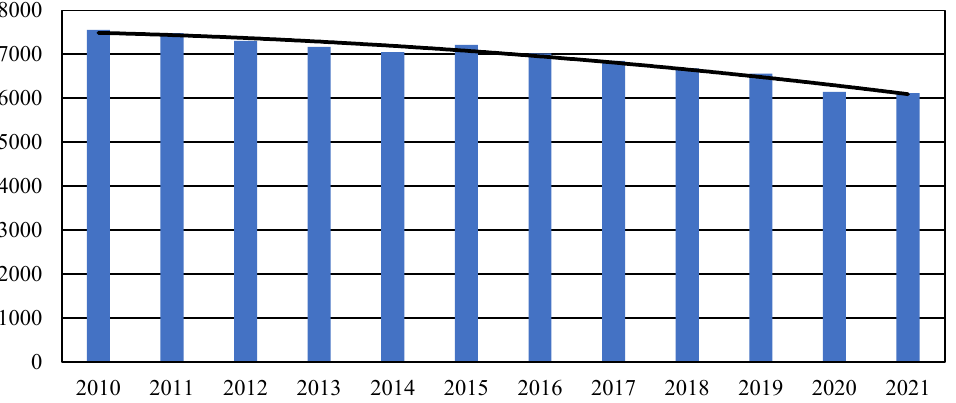
Figure 9. The potential of livestock by ‐ products for production of gas ‐ like types of fuel in the coun ‐ ties (thous. m 3 ).